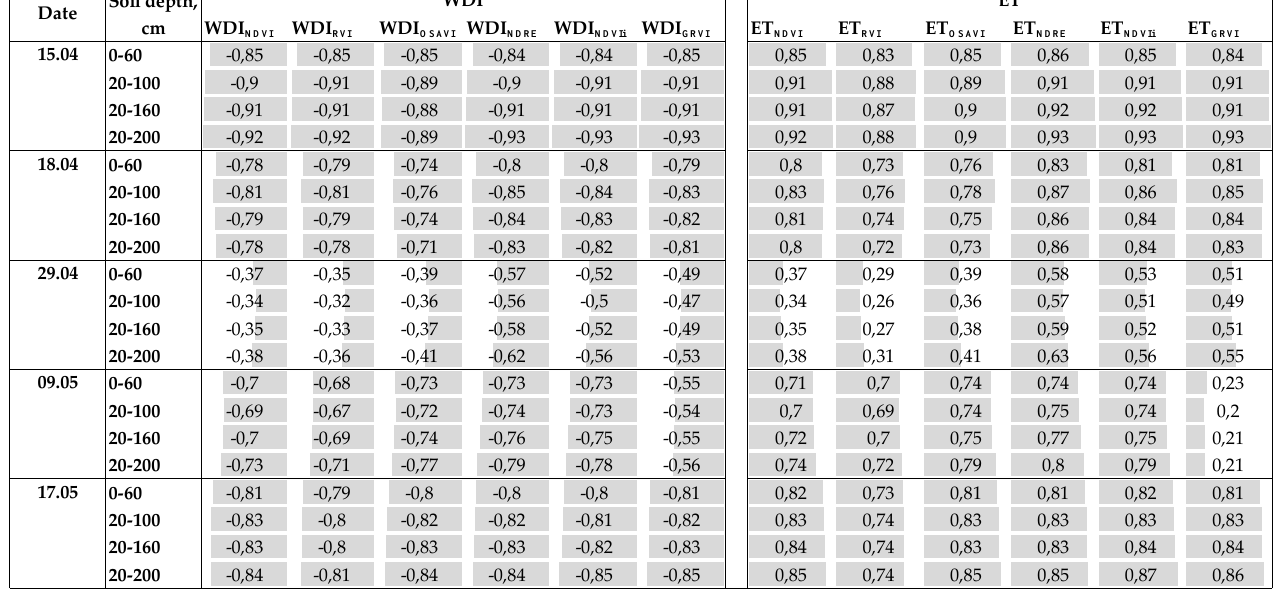
Figure 8. Seasonal change of fraction of transpirable soil water (FTSW) in March–May 2019 calcu- lated from the volumetric soil water content measured with the neutron probe. The treatment names A–F refer to treatments from the lowest to the highest irrigation amounts, respectively, with the numbers next to the letter corresponding to the replicate number.